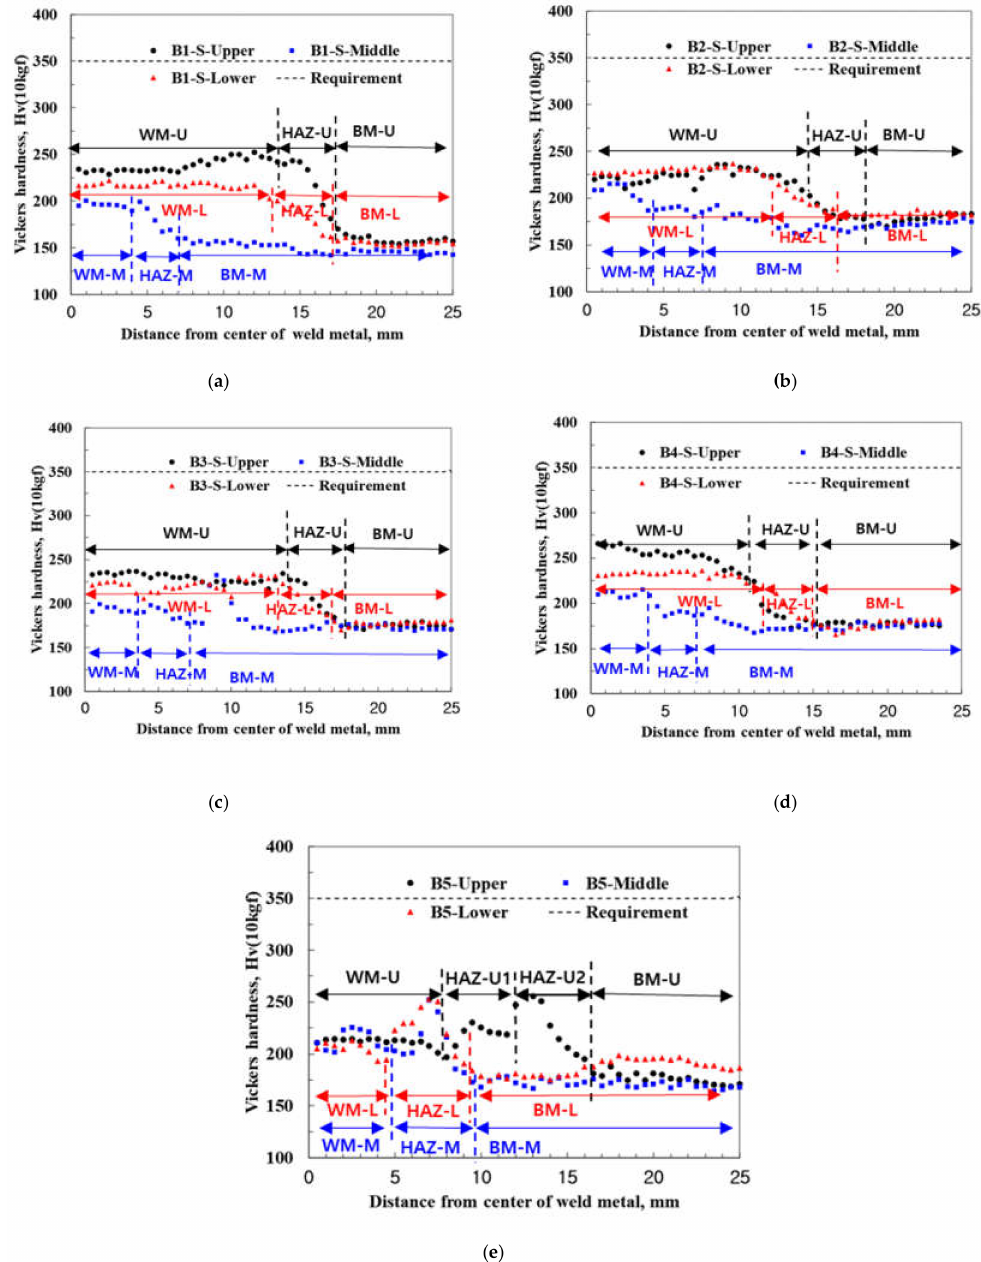
Figure 7. Hardness test (Hv10) for removal of the run-off plate in butt joint: specimens ( a ) B1; ( b ) B2; ( c ) B3; ( d ) B4; and ( e )